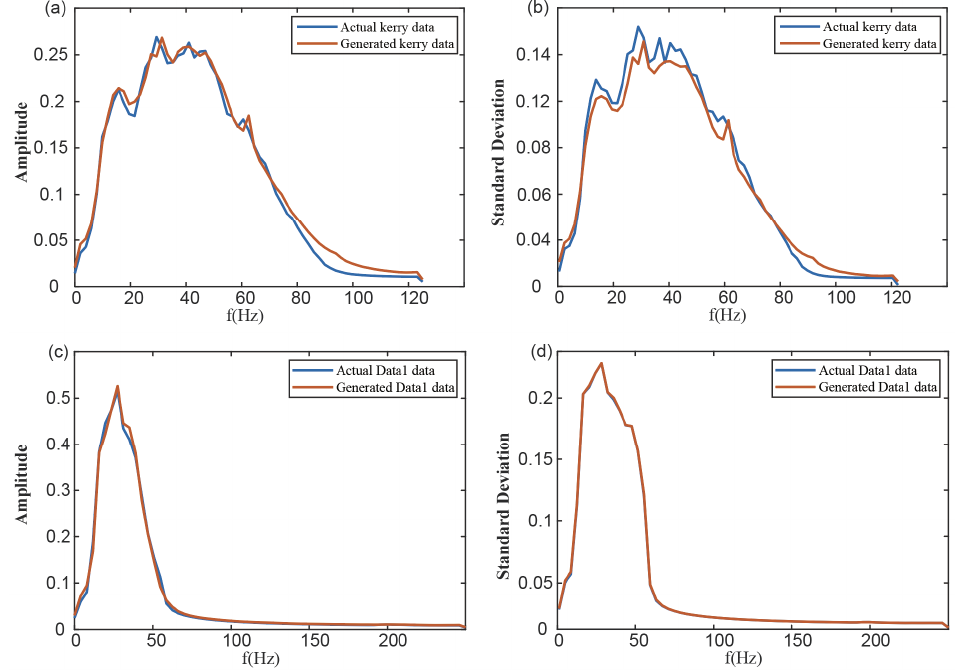
Figure 5. The average frequency spectra for Kerry ( a ) and Data1 ( c ), and the standard deviation of frequency spectra for Kerry ( b ) and Data1 ( d ), computed on 1000 samples.